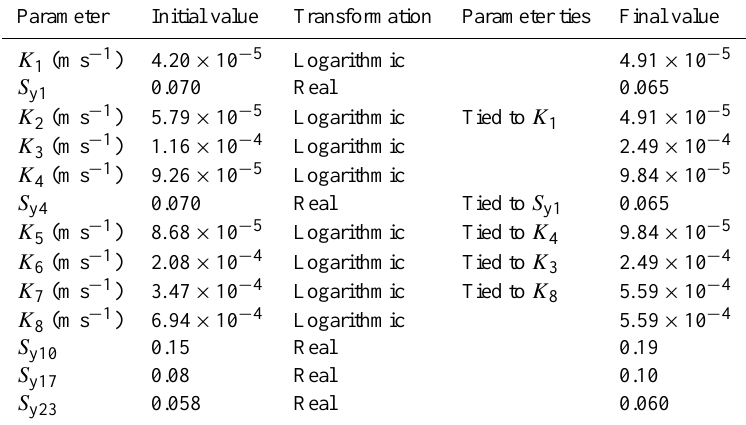
Table 6. Parameters selected for auto-calibration as well as their final values after the calibration process. K i is horizontal conductivity for geological unit i ( i is a positive integer), S y ( i ) is storage coefficient for geological unit i